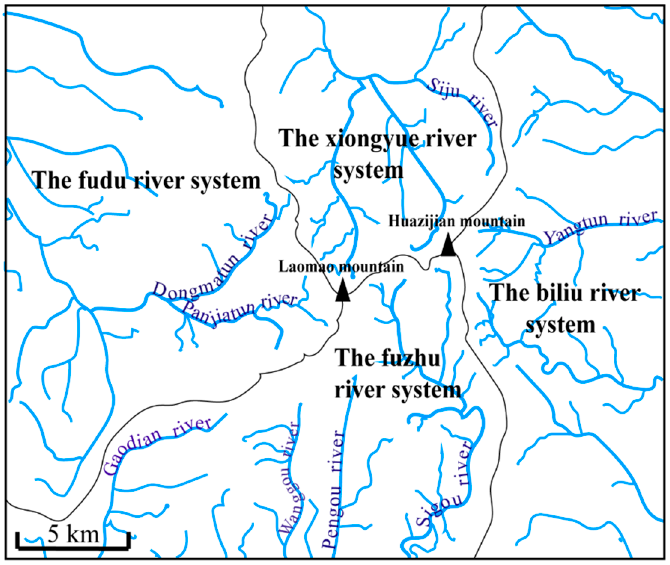
Figure 4. Water shed and river distribution system in the Laomao Mountain area.